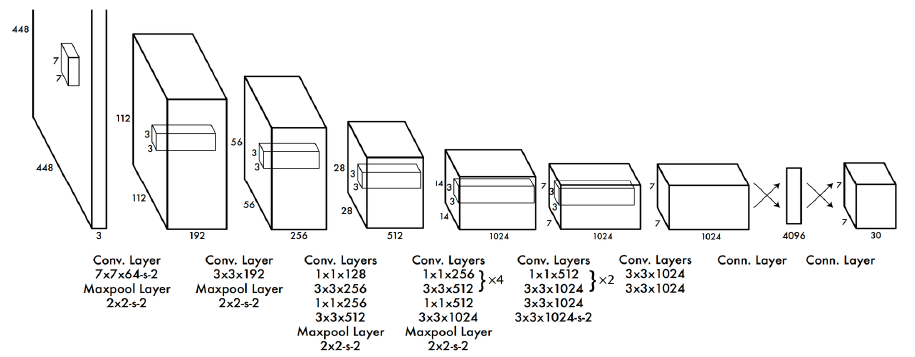
Figure 1. YOLO algorithm architecture.